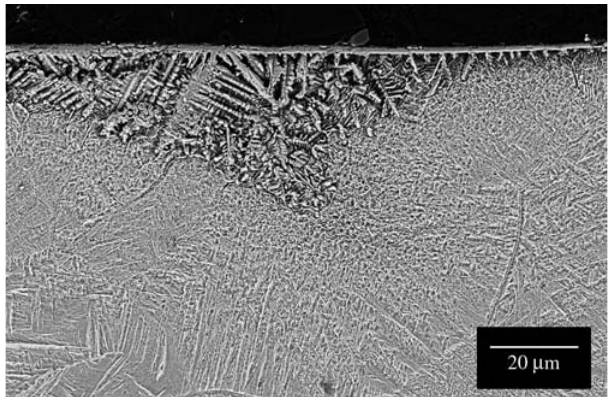
Figure 8. Detail of TiN dendrites near to the materials